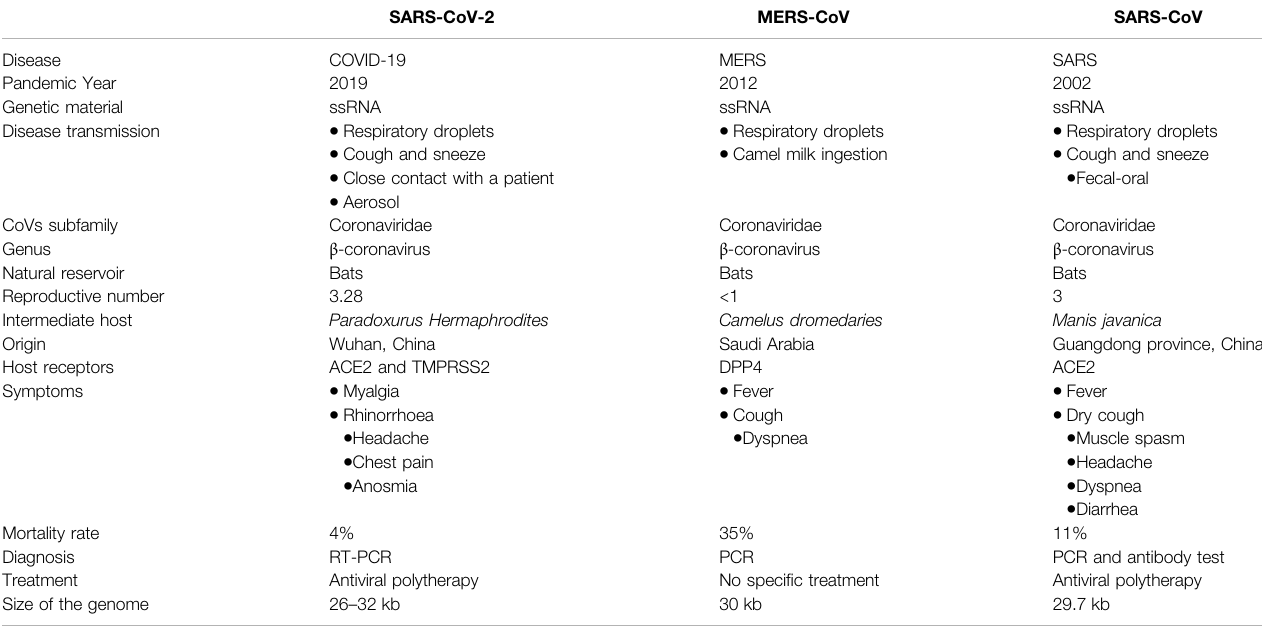
TABLE 2 | Comparison between SARS-CoV-2, MERS-CoV, and SARS-CoV.